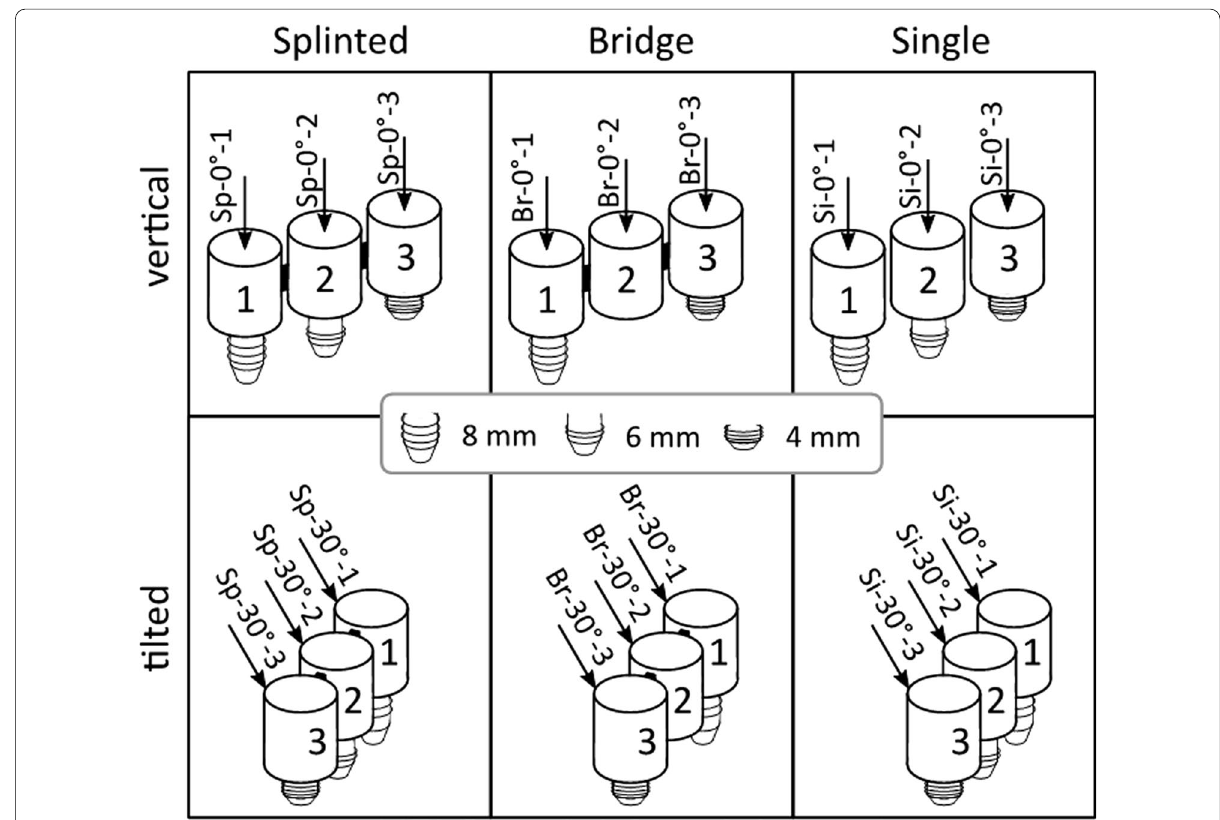
Fig. 1 Overview of test configurations. Left: splinted (Sp) crowns on 3 implants. Centre: 3-unit bridge (Br) supported by 2 outer implants with the middle implant missing. Right: Single (Si) crowns on 3 implants. Each crown/unit is loaded separately: 2nd premolar (1), 1st molar (2), and 2nd molar (3). All loads (arrows) are applied vertically (top column, 0°) or tilted at 30° (from buccal to lingual, bottom column). Implant length sequence: 8 mm—6 mm—4 mm from 2nd premolar to 2nd molar